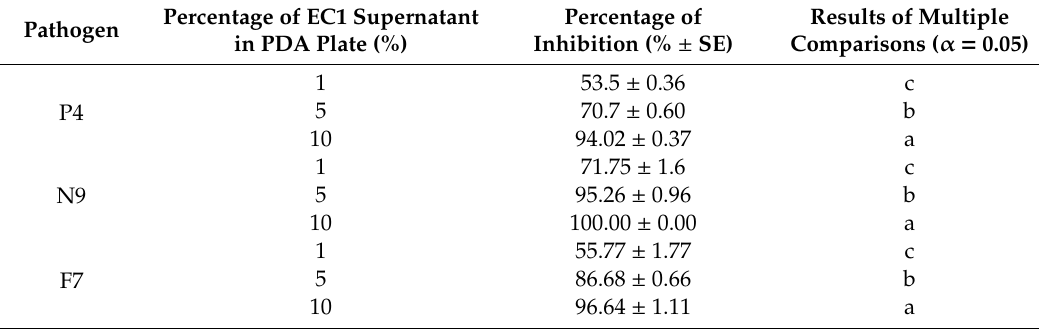
Table 5. Inhibitory activity of EC1 supernatant against the five identified